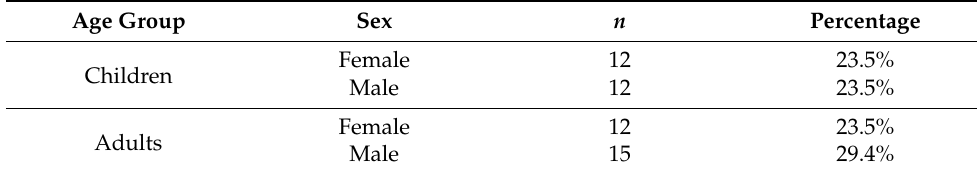
Table 1. General characteristics of patients ( n =